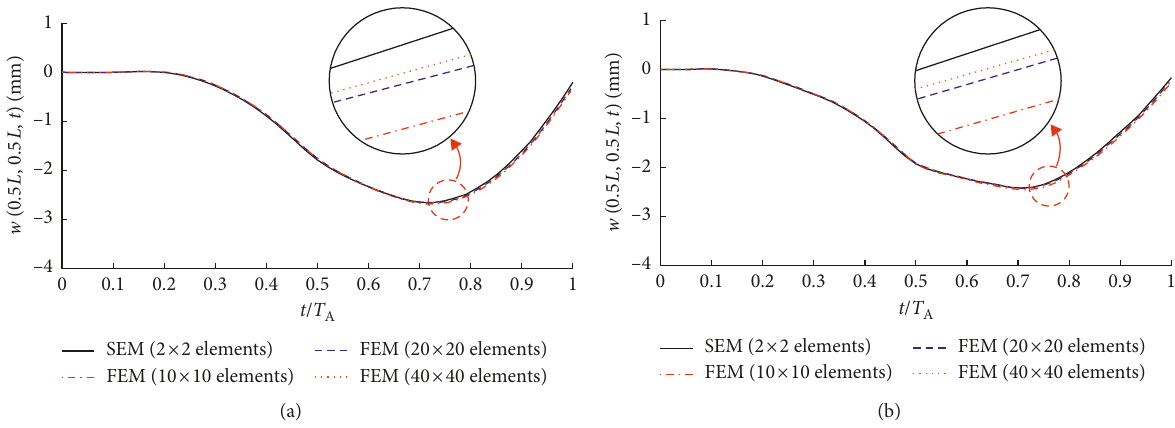
Figure 13: Comparison of the vibration responses obtained by the FEM [14] and SEM at the center of the S-S-S-S square plate (Example 1) subjected to a moving point force whose trajectory is given by (a) Case 2 of (39), where v 0